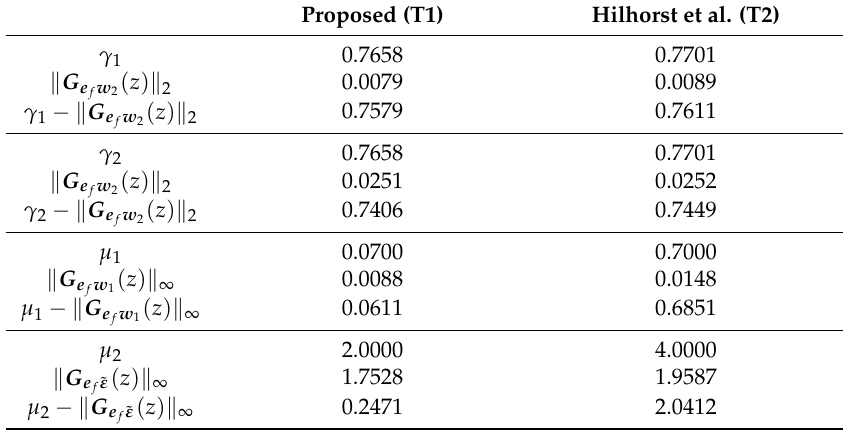
Figure 11. Trade-off between ( z ) < γ G e 2 for proposed Theorem 1 (T1) and Theorem 2 (T2) based on [39]. f w 2 (cid:107) (cid:107) 2 Table 2. The minimal values of µ 1 and µ 2 for which the constraints (59) are